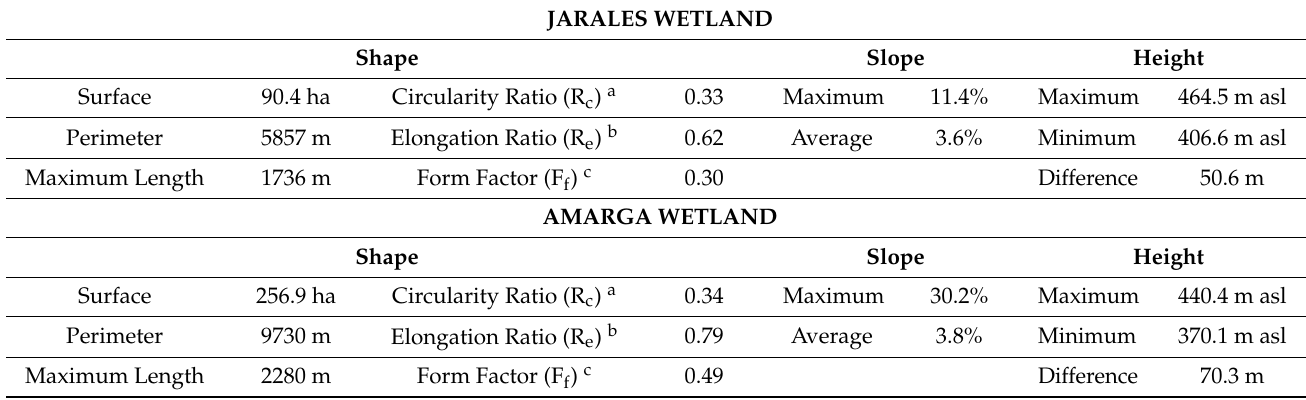
Table 1. Morphological information of the wetland watersheds obtained from the DTM.